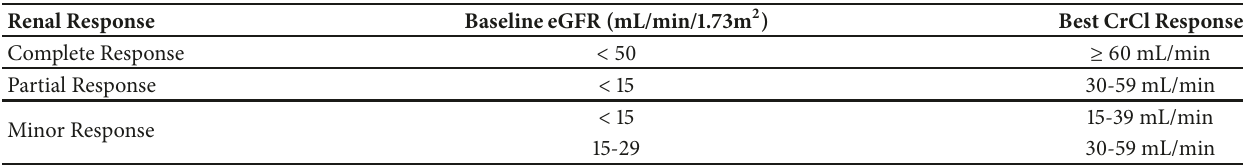
Table 1: Renal response criteria ∗